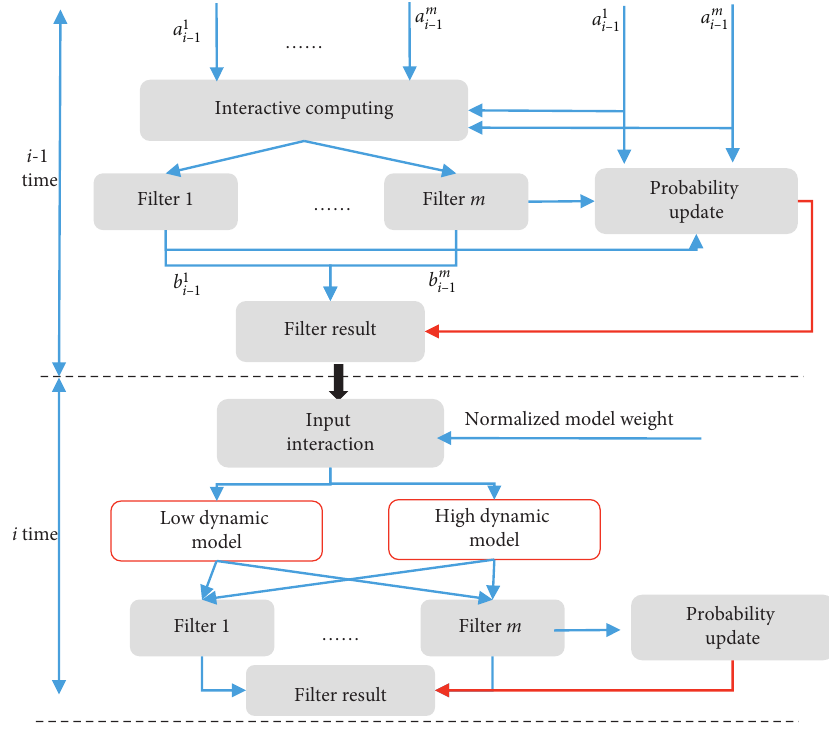
Figure 1: Structure diagram of IMM